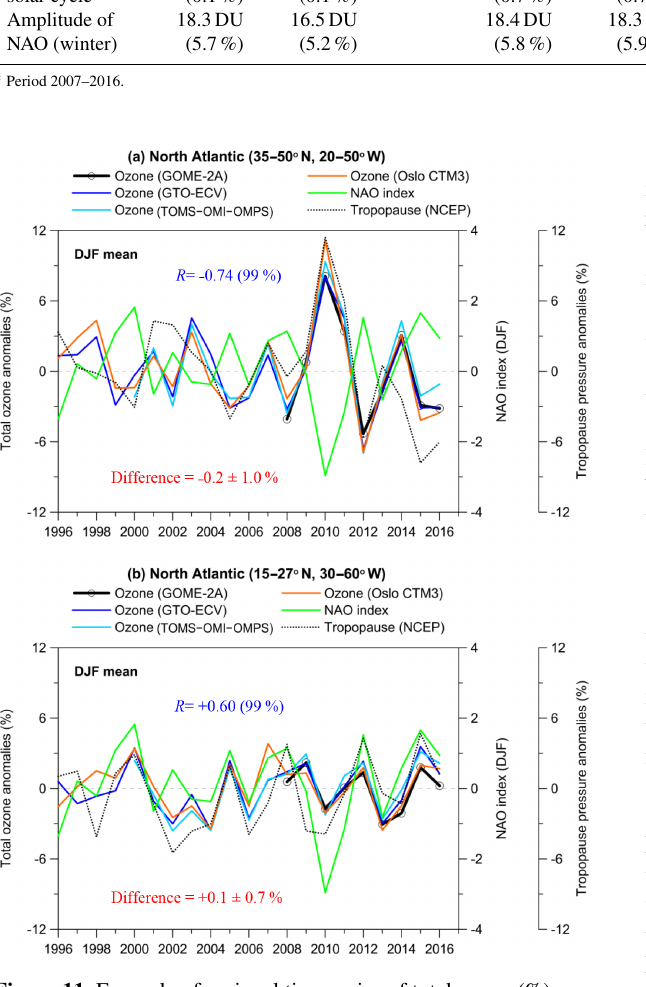
Figure 11. Example of regional time series of total ozone (%) over the North Atlantic regions (a) 35–50 ◦ N, 20–50 ◦ W, and (b) 15– 27 ◦ N, 30–60 ◦ W, in winter (DJF mean) along with the NAO index. The dotted line shows the respective tropopause pressure variabil- ity from NCEP reanalysis. R is the correlation coefficient between GTO-ECV total ozone and the NAO index. The differences refer to the mean differences ± σ (in %) between GTO-ECV and the com- bined TOMS–OMI–OMPS satellite